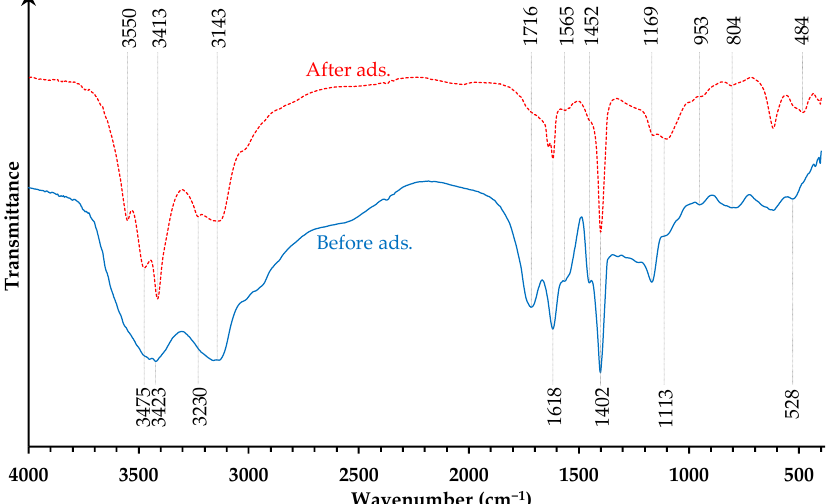
Figure 2. FT–IR spectra of poly(acrylic acid/chestnut shell pigment) before and after Cu(II) adsorp- tion.